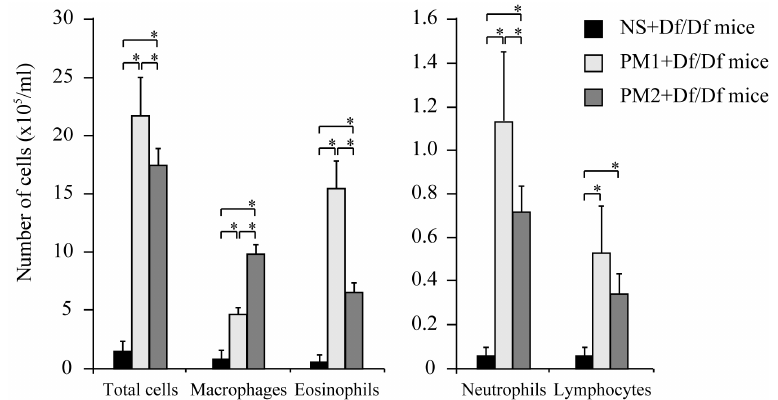
Figure 1. Total and differential leukocyte counts in bronchoalveolar lavage fluid (BALF). Mice were divided to three sensitized groups that were all subsequently challenged using Dermatophagoides farina (Df): normal saline with Df (NS + Df/Df), particulate matter 1 (7–28 February 2013) with Df (PM1 + Df/Df), and particulate matter 2 (7–28 April 2013) with Df (PM2 + Df/Df). Cell counts (eosinophils, macrophages, neutrophils, and lymphocytes) in the BALF were obtained at 24 h after the challenge on day 11. The total cell counts from PM1 + Df/Df mice were significantly higher, compared to those from PM2 + Df/Df mice. Data for each group are expressed as mean ± standard deviation, and the results are from eight mice per group. * p < 0.05.